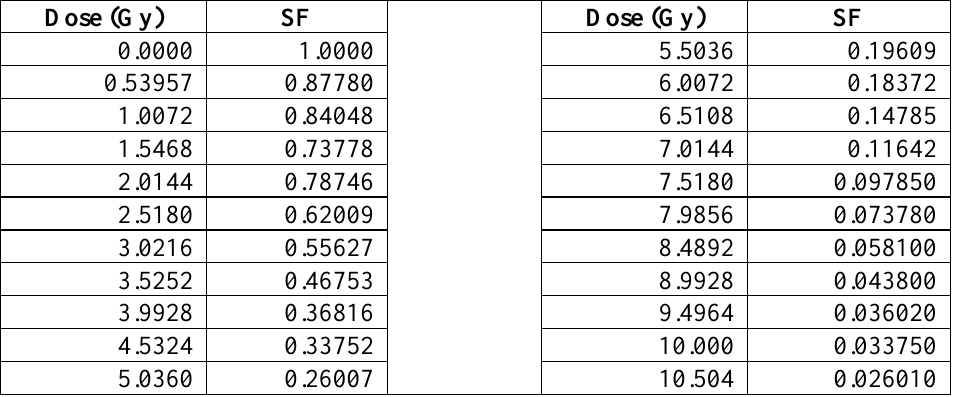
Table n. 2: Numerical data relating to the graph in figure 3, further